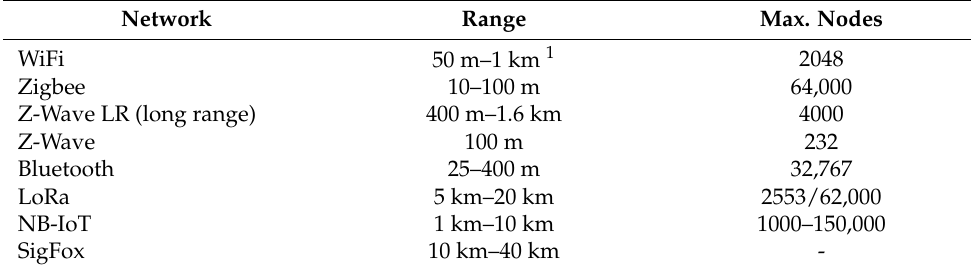
Table 2. Networks suitable for use in agricultural IoT wireless systems [38–47].